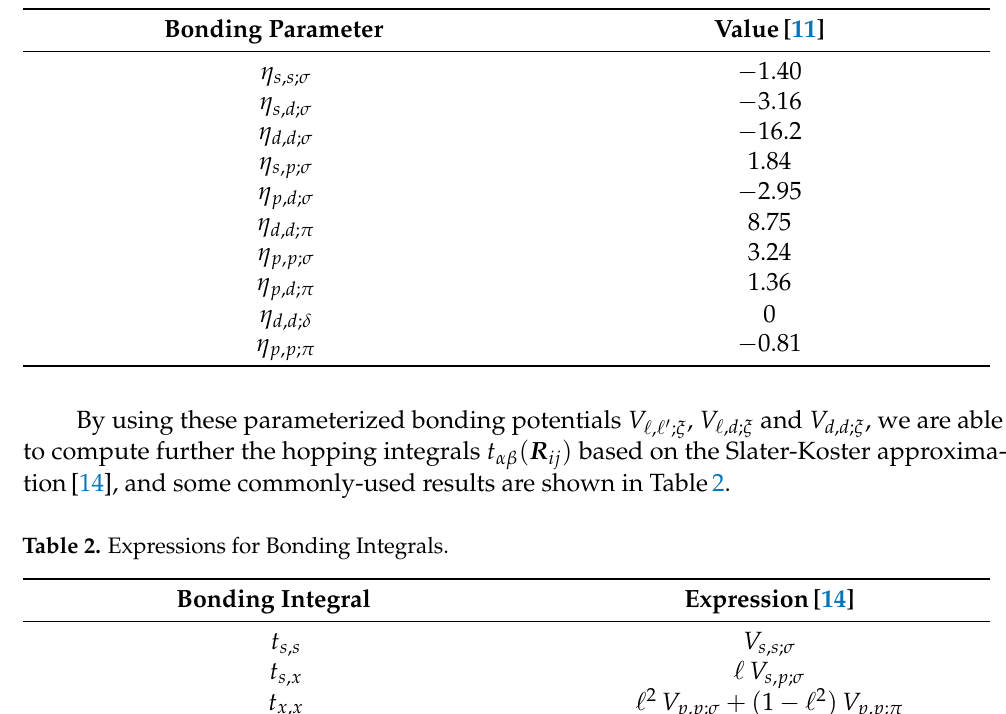
Table 1. Inter-atomic bonding parameters.